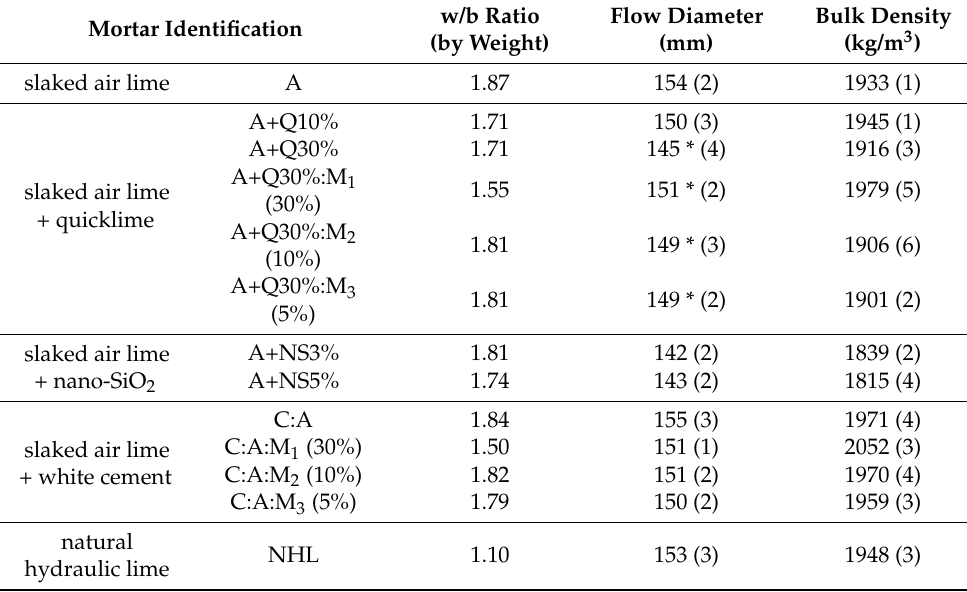
Table 3. Fresh mortars